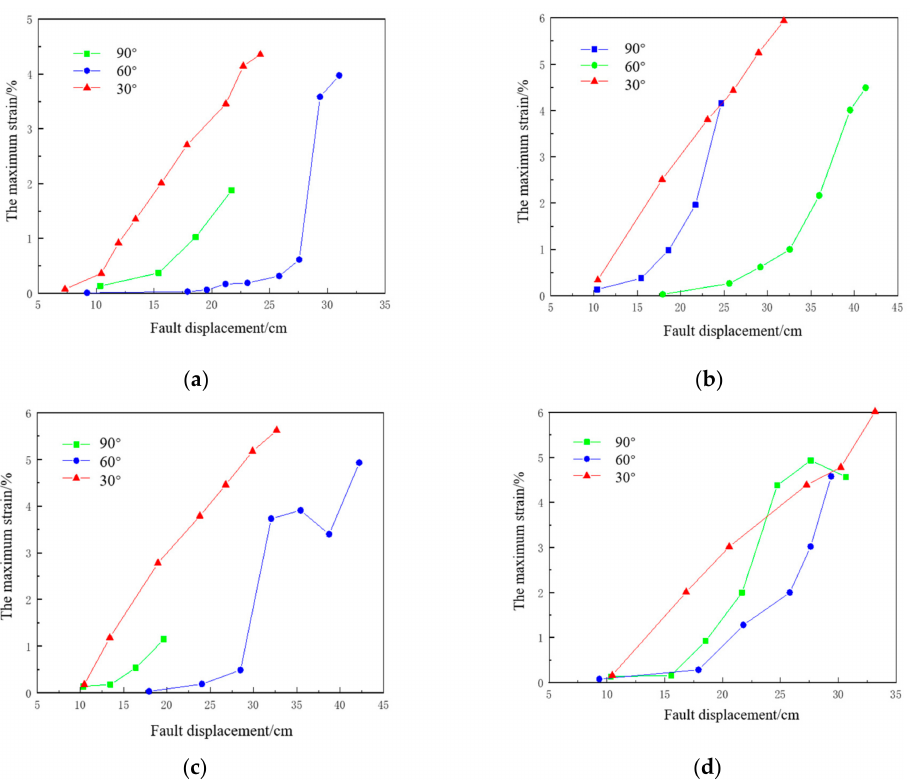
Figure 15. The maximum strain change law of pipeline under different included angles: ( a ) 323.9 × 7.1; ( b ) 323.9 × 7.5; ( c ) 323.9 × 8.0; ( d ) 323.9 × 8.5.